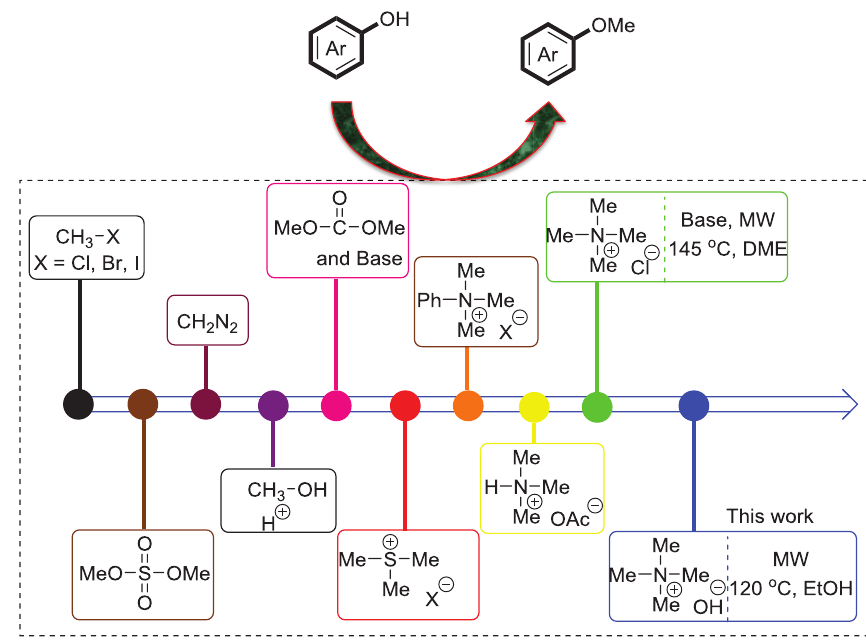
Figure 1: Different methylating agents used for O-methylation of phenolic